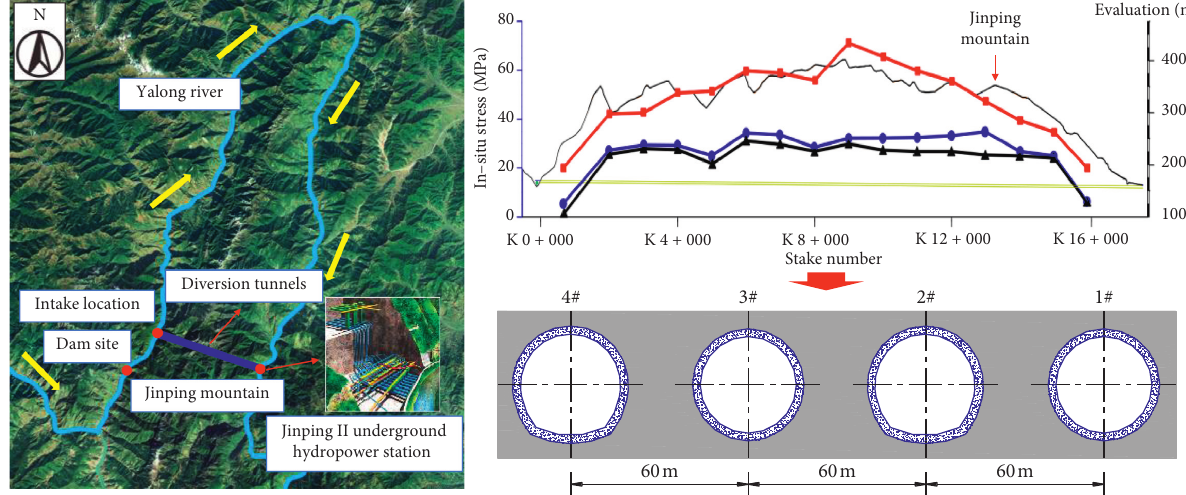
Figure 1: Layout of the Jinping II diversion